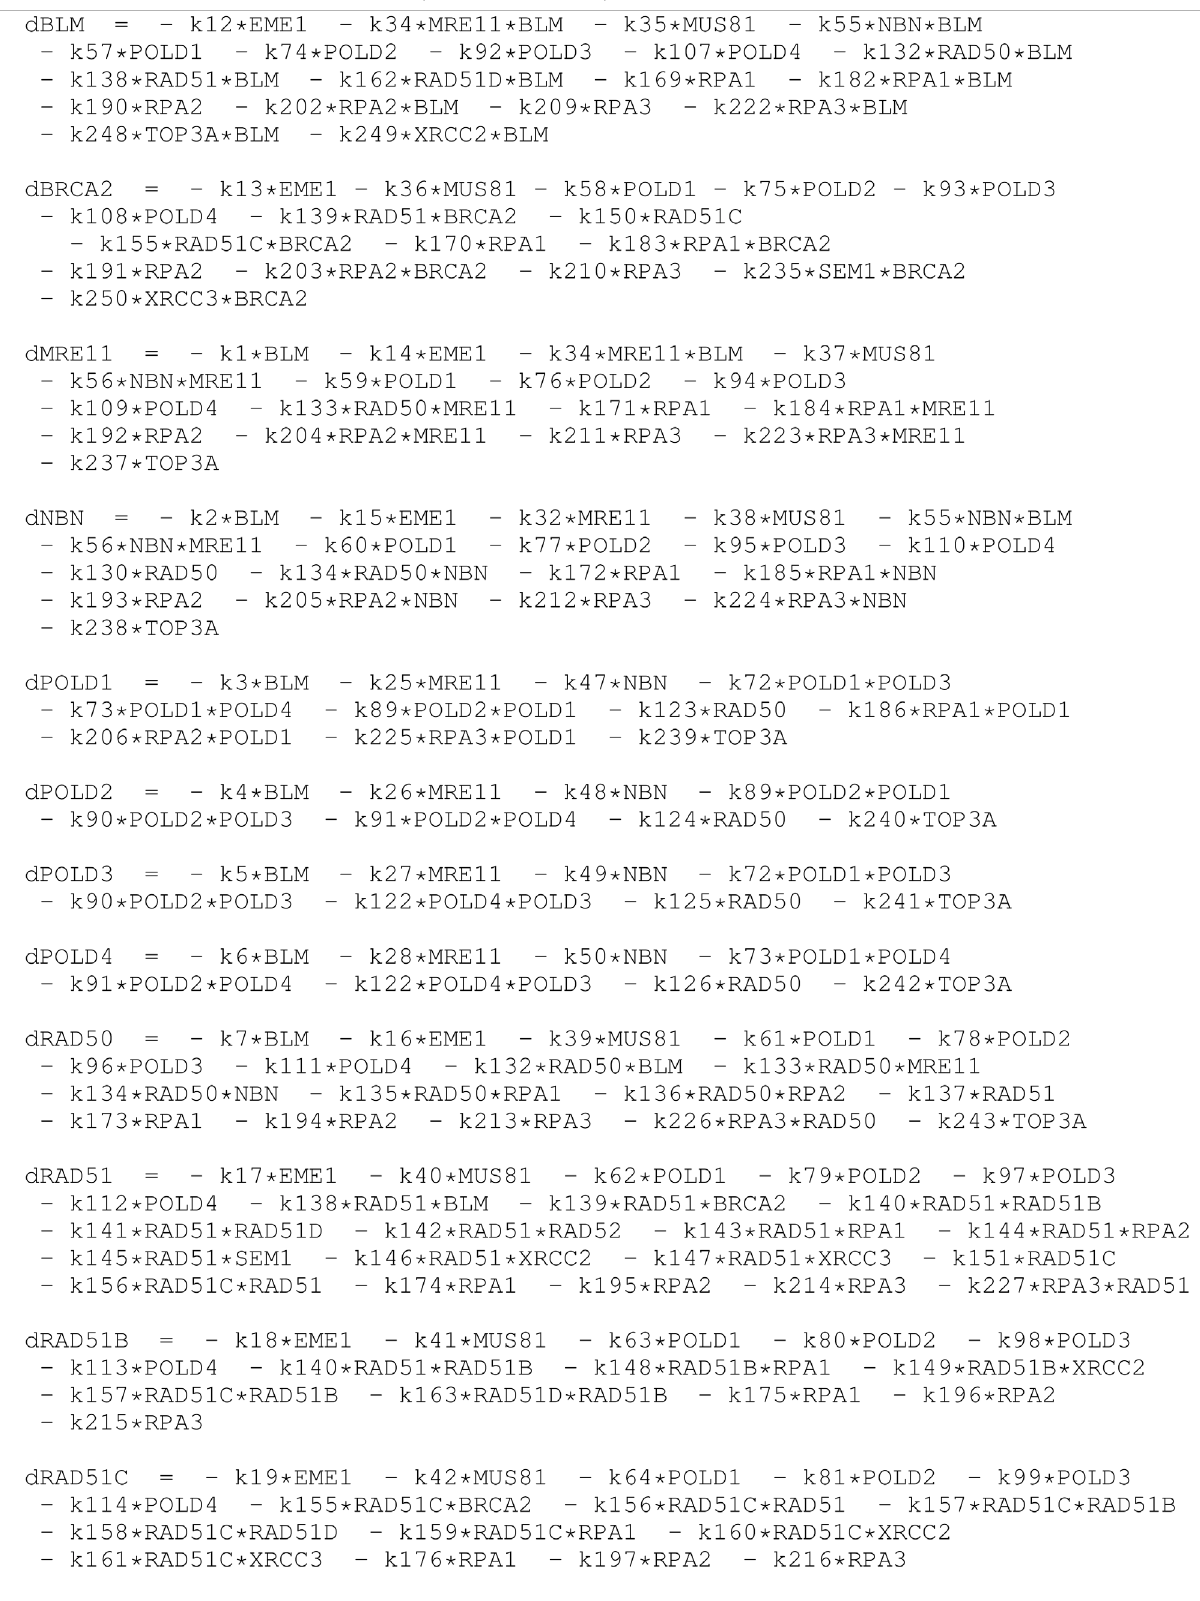
TABLE 5| ThisisthePARTIofthetable ofordinarydifferentialequationsofthedynamicsofHRnetwork,inRcodeformalism.The k followedbyanumberdenotethekinetic rate constant, and the letter “ d ” in front of the name of the proteins denote the temporal derivative of it concentration.